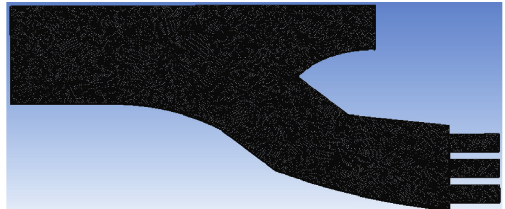
Figure 2: 3D model